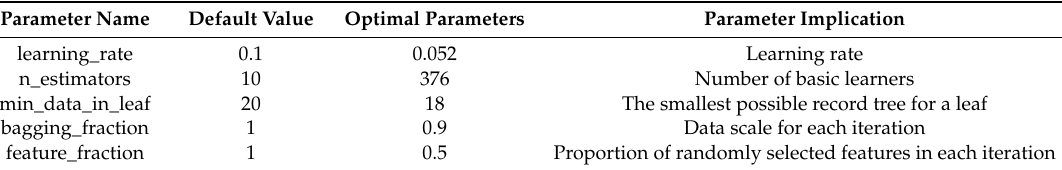
Table 2. The optimal parameters of the LightGBM